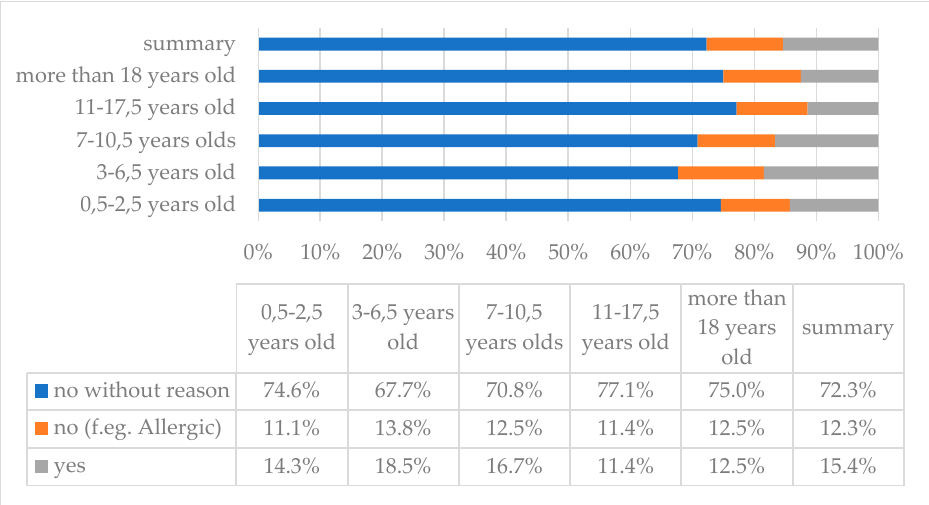
Figure 7. Nut consumption in the study group of people with DS by age.